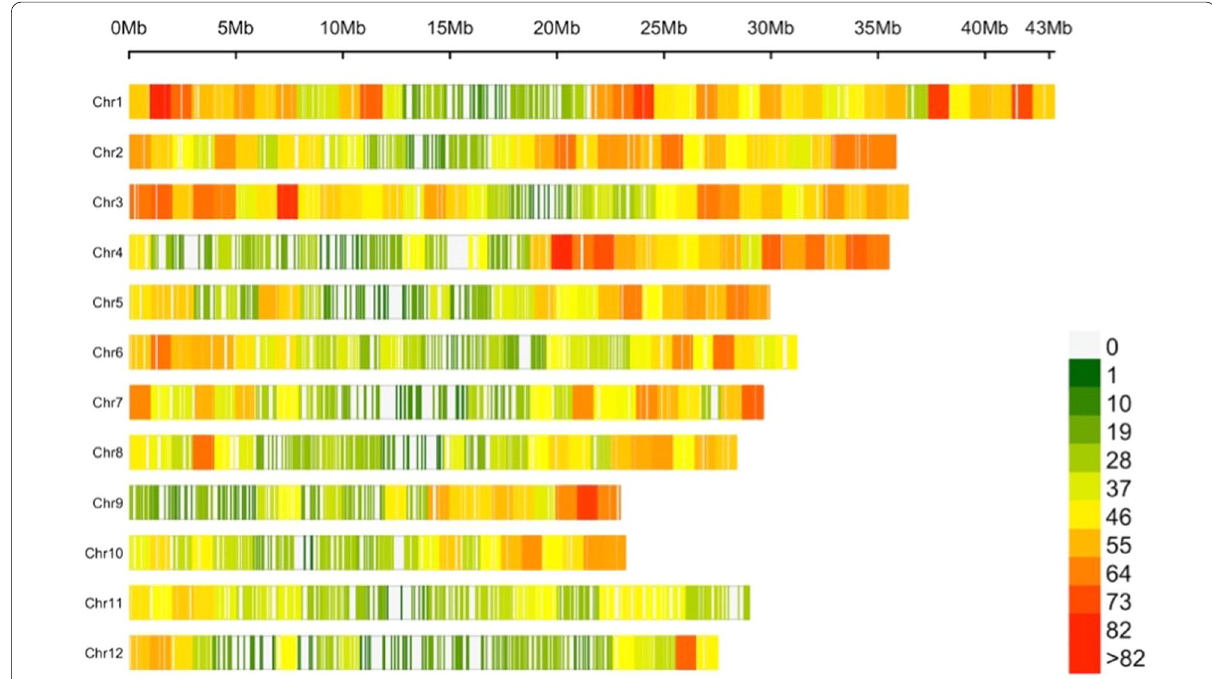
Fig. 4 Number of SNPs within 1 Mb window for all the 12